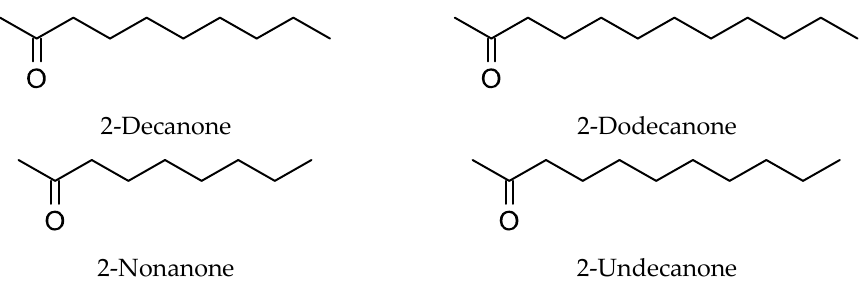
Figure 2. Major long-chain aliphatic ketones found in the Ruta essential oils.